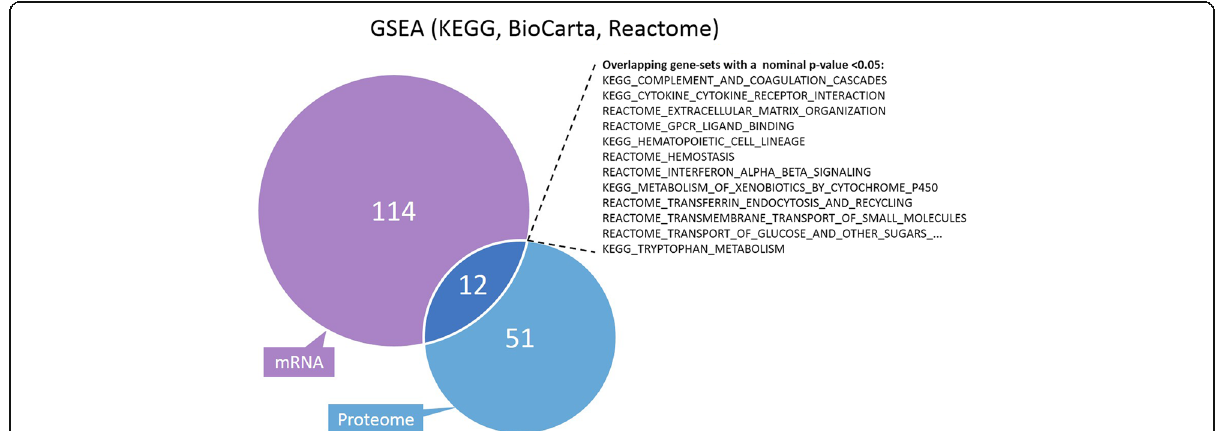
Fig. 6 GSEA analyses show overlapping gene-sets significantly enriched with changes in the transcriptome (mRNA) and proteome. The pre-ranked GSEA analyses, with all genes ranked by their adjusted p -values ( − log 10 transformed) from two-sample moderated t-tests, between FLs1 and NLSdel. GSEA analyses were conducted separately for the transcriptome (mRNA) and proteome, with the KEGG, BioCarta, and Reactome